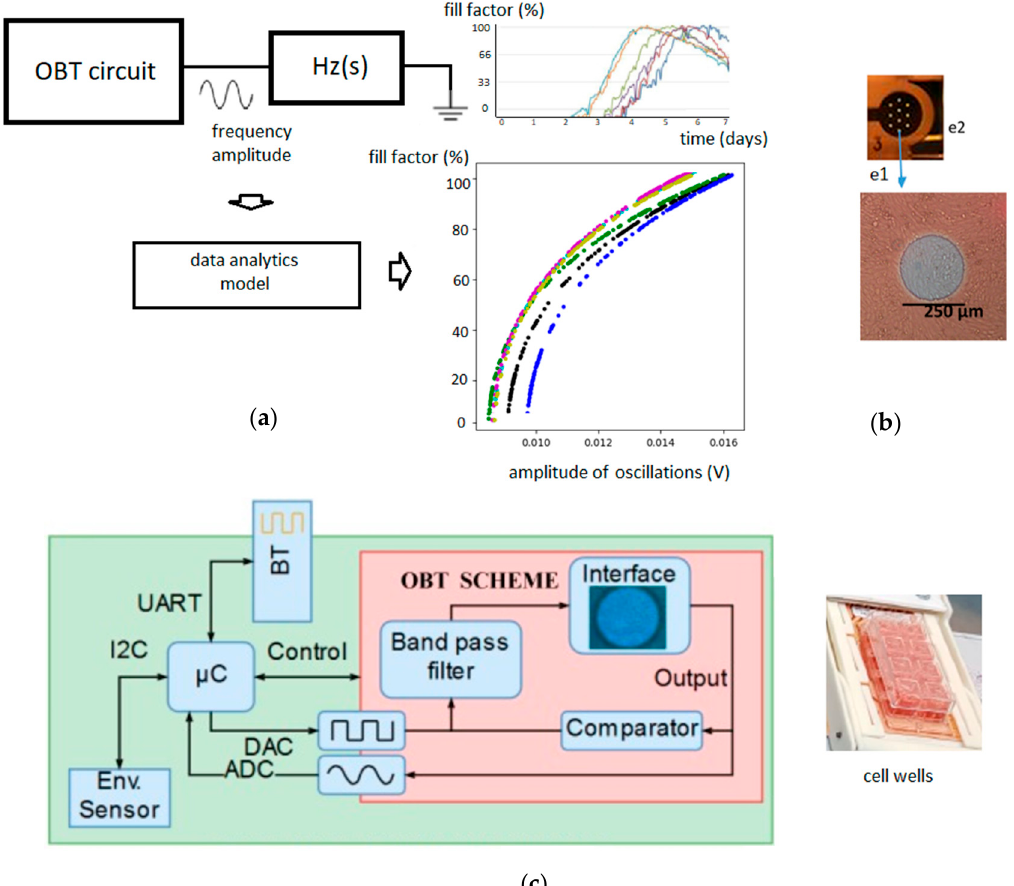
Figure 1. Oscillation-based technique and data-analytics model. ( a ) The oscillation-based technique (OBT) circuit is connected to the Hz(s), the bio-impedance block, which includes the Zcell-electrode. A full description of the OBT circuit is presented in [12]. The frequency and amplitude of each oscillation produced by the OBT circuit are the input parameters for the data-analytics model. The fill-factor of the cell culture and its evolution with the amplitude or frequency of OBT signals is the parameter we want to predict; ( b ) Detail of one of the eight wells of the 8W10E PET cultureware from Applied Biophysics [15] that were used in the experiments, where e1 is one of the 10 circular gold electrodes (the sensing area is the sum of the 10 gold electrodes) and e2 is the reference or ground electrode. Each well has in total an area of 0.8 cm 2 ; ( c ) Hardware prototype scheme for the sensor device, used for the wireless monitoring of the cell culture data [14].